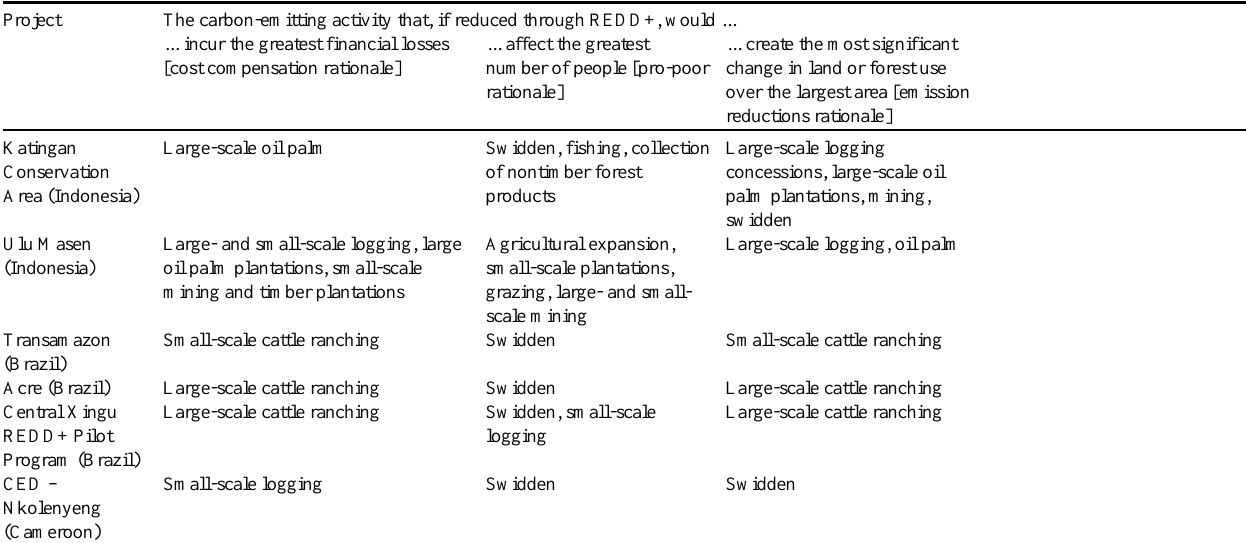
Table 6 . The “most significant” potential opportunity costs of six REDD+ projects, showing the variation in actors depending on the indicators used to define “significant.” Projects were selected for this table to reflect a range of land use activities. †